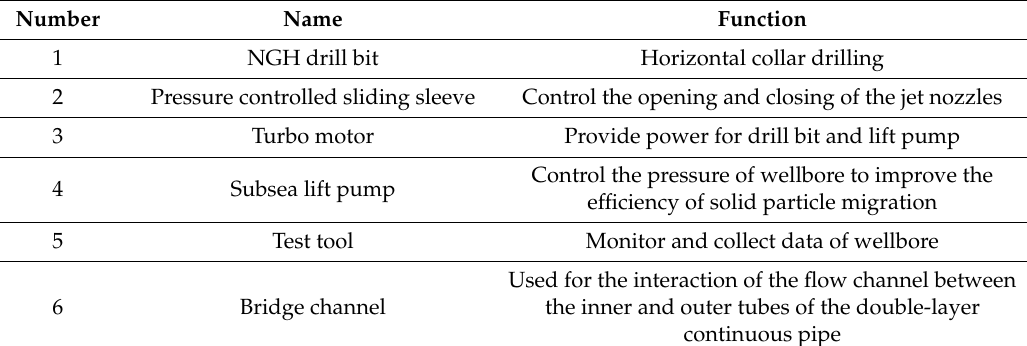
Table 1. Main tools and functions of drilling and production tool